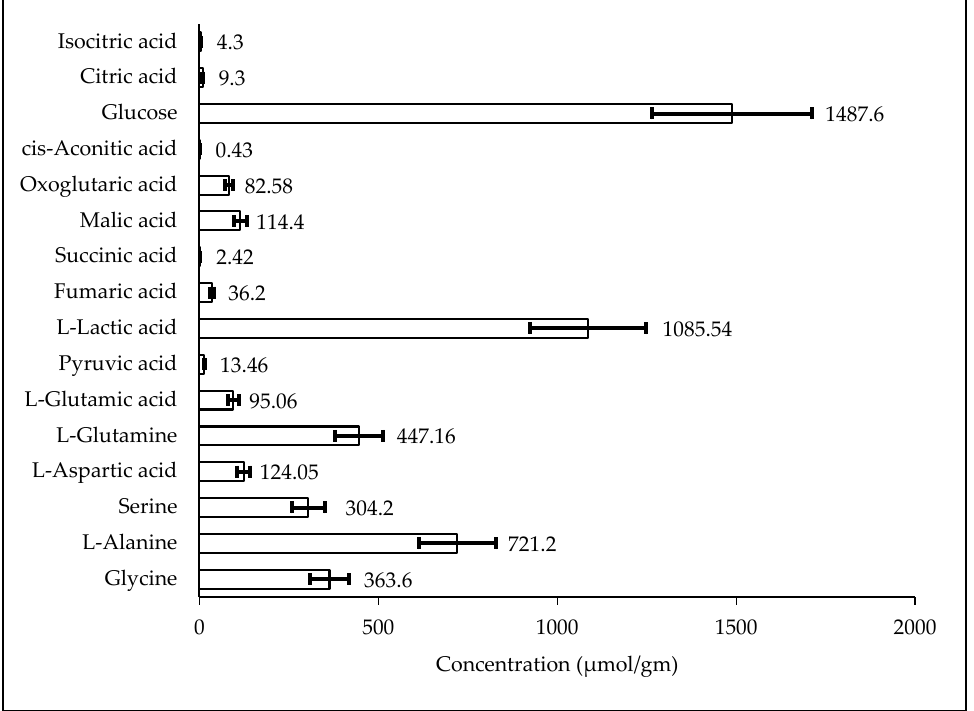
Figure 6. Result of TCA cycle intermediate in murine liver tissue.